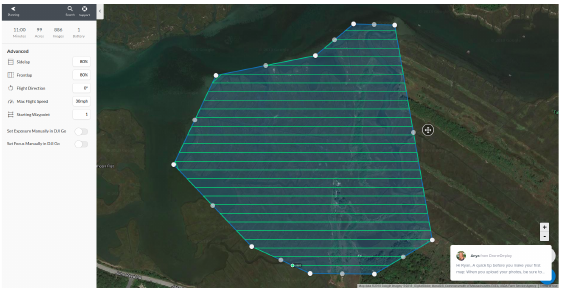
Figure 3. Low Tide Drone Deploy Flight